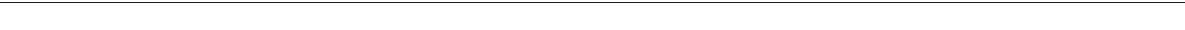
Fig. 3 B cell-speci fi c CD1d is critical for α -GalCer-iNKT cell amelioration of arthritis. a Mean clinical score of B-WT chimeric mice (left) and B- Cd1d − / − chimeric mice (right) that received α -GalCer or vehicle alone following induction of arthritis. The Y axis shows the percentage of swelling in antigen- injected knee compared to control knee (B- Cd1d − / − ± α -GalCer n = 5 per group, B-WT ± α -GalCer n = 4 per group, one of three experiments is shown). b Representative fl ow cytometry plots and bar charts showing the frequency (top) and number (bottom) of splenic IFN- γ + and IL-17 + CD4 + T cells in B- Cd1d − / − and B-WT chimeric mice that received α -GalCer or vehicle alone ( n = 3 per group, one of two experiments is shown). c Representative fl ow cytometry plots and bar charts showing the frequency and number of splenic iNKT cells in B- Cd1d − / − and B-WT mice that received α -GalCer or vehicle alone ( n = 3 per group, one of two experiments is shown). d Representative histograms and bar chart showing MFI of Ki-67 in splenic iNKT cells from α - GalCer- or vehicle-treated B- Cd1d − / − and B-WT mice ( n = 3 per group, one of two experiments is shown). e Representative histograms and bar chart showing MFI of PLZF in splenic iNKT cells from α -GalCer- or vehicle-treated B- Cd1d − / − and B-WT mice ( n = 3 per group, one of two experiments is shown). f Representative fl ow cytometry plots and bar chart showing the frequency of IFN- γ + PLZF + splenic iNKT cells from α -GalCer- or vehicle-treated B- Cd1d − / − and B-WT mice ( n = 4 per group, one of two experiments is shown). g Representative histograms and bar charts showing MFI of T-bet and GATA3 in splenic iNKT cells from α -GalCer- or vehicle-treated B- Cd1d − / − and B-WT mice ( n = 3 per group, one of two experiments is shown). h Representative immuno fl uorescence showing the localization of splenic NK1.1 + CD3 + T cells and IgD + B cells in B- Cd1d − / − and B-WT chimeric mice that received α -GalCer or vehicle alone. Arrowheads point to NK1.1 + CD3 + cells. Bar, 100 μ m, inset bar, 5 μ m ( n = 3 per group, one of two experiments is shown). i Mean clinical score of B- Il10 − / − chimeric mice (right) and B-WT chimeric mice (left) that received α -GalCer or vehicle alone following induction of arthritis; the Y axis shows the percentage of swelling in antigen-injected knee compared to control knee (B- Il10 − / − ± α -GalCer n = 5 per group, B-WT ± α -GalCer n = 6 per group, one of two experiments is shown). b Analyzed on day 7 post disease onset, c , d , h analyzed on day 3 post disease onset, and e – i analyzed at 16 h post disease onset. Data are mean ± s.e.m. * p < 0.05, ** p < 0.01, *** p < 0.001, and **** p < 0.0001 ( a , i two-way ANOVA, b – g one-way